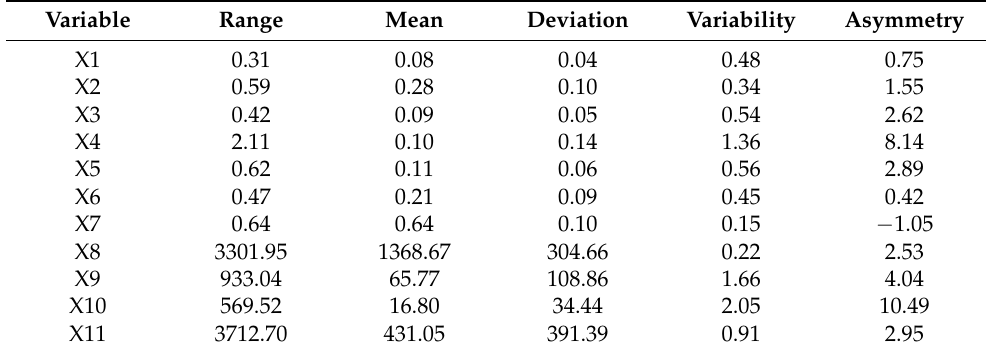
Table 2. Statistical characteristics of the diagnostic variables for the financial potential of rural communes in eastern Poland (in